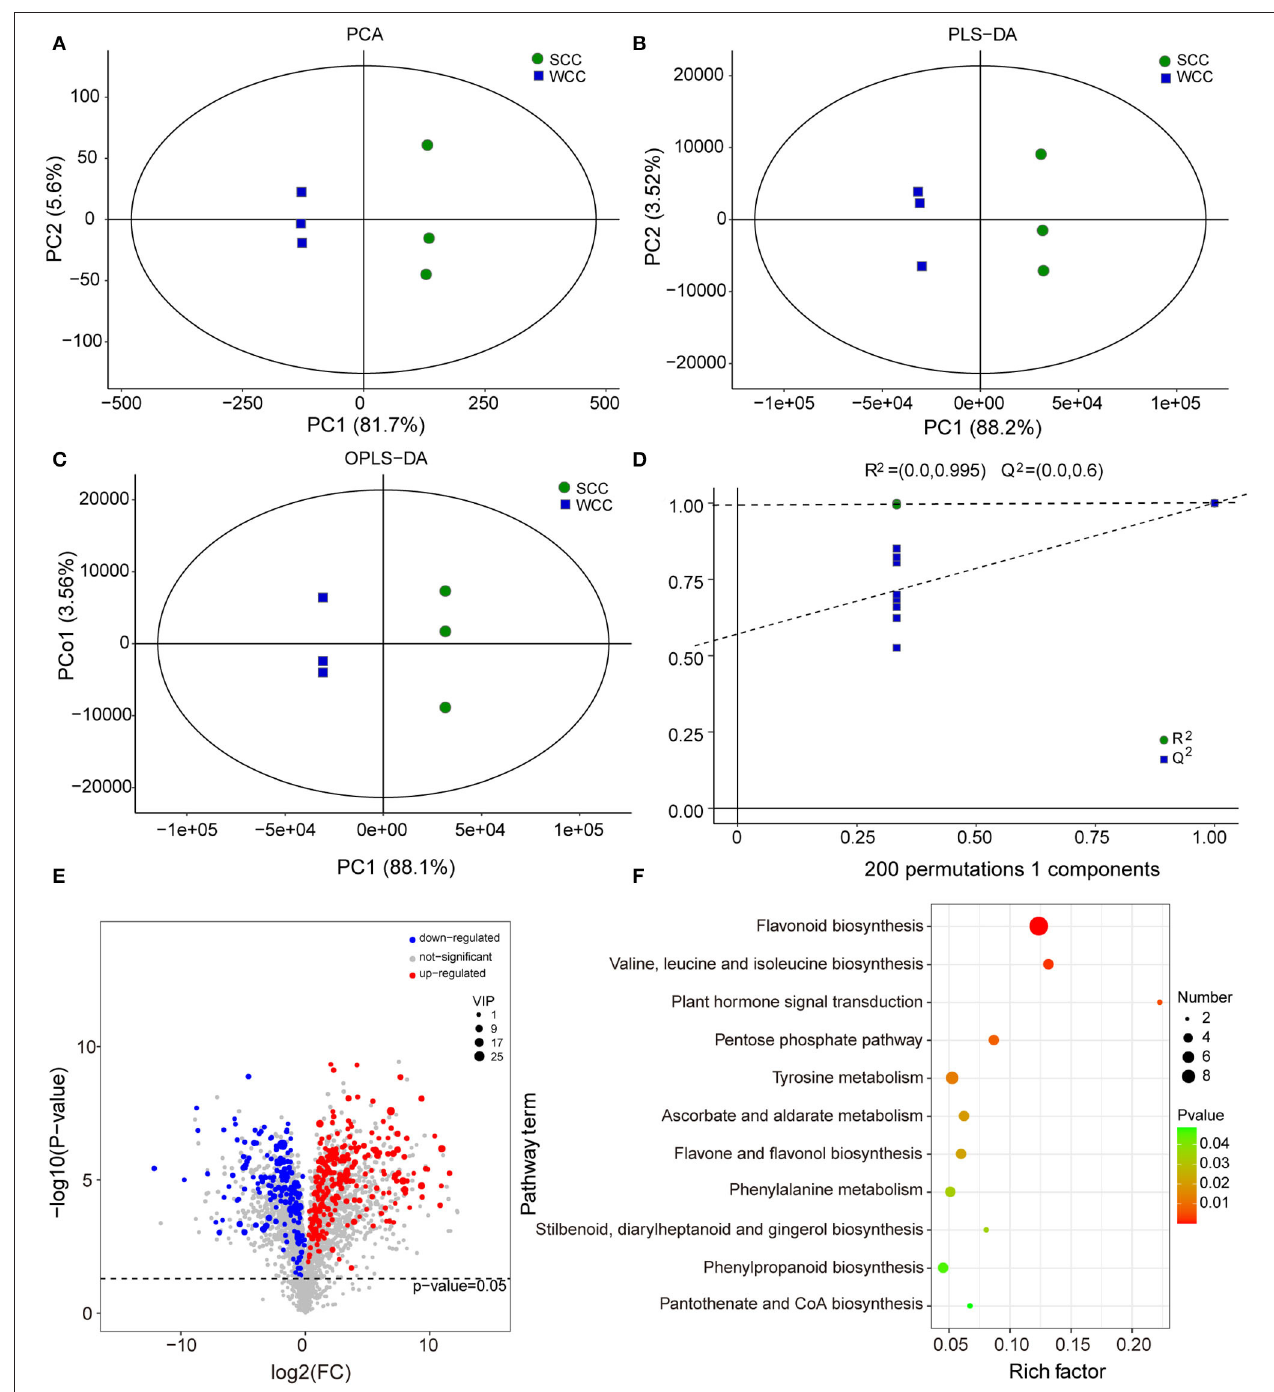
FIGURE 3 | Multivariate statistical analysis of the differentially synthesized metabolites (DSMs) based on liquid chromatography-mass spectrometry (LC-MS). (A) Plots of principal component analysis (PCA); (B) partial least squares discriminant analysis (PLS-DA); and (C) orthogonal PLS-DA (OPLS-DA). The x - and y -axes represent the first (PC1) and second (PC2)/orthogonal (PCo1) principal components, respectively. SCC and WCC represent summer and winter C. fortunei needles, respectively. (D) The 200-response sorting tests of the OPLS-DA model. (E) Volcano plot of DSMs. Each point in the volcano plot represents a metabolite, the abscissa represents the logarithm of the quantitative difference multiplied by a metabolite in two samples, and the ordinate represents the significance level of DSMs. The blue/red dots in the figure represent down/upregulated DSMs, and the gray dots represent metabolites that were detected but not significant. (F) KEGG analysis of DSMs. The x - and y -axes represent the enrichment factor and pathway term, respectively. The colors and sizes of the dots represent the significance ( p ) and number of metabolites, respectively.